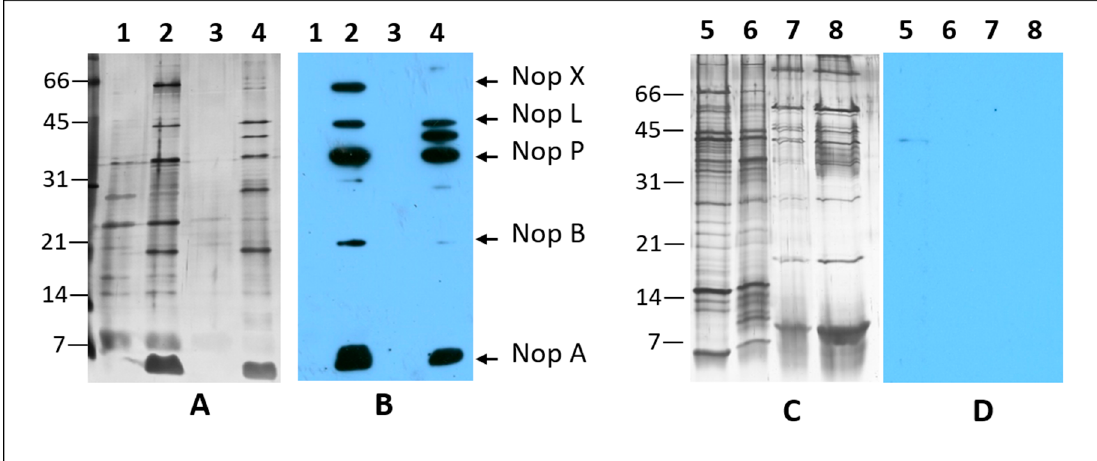
Figure 2. Extracellular protein profile and immunoblot analysis of Nops. Extracellular proteins produced by S. fredii USDA191 (lanes 1 and 2), RCB26 (lanes 3 and 4), B. diazoefficens USDA110 (lanes 5 and 6), and ∆ 136 (lanes 7 and 8) were resolved by 15% SDS-PAGE and silver stained ( A , C ) or transferred to nitrocellulose membrane for immunoblot analysis ( B , D ). Nops were detected with a cocktail of antibodies raised against individual Nop proteins. Odd and even number lanes contain proteins isolated from cells grown in the absence or presence of 1 µ M apigenin or genistein, respectively. The size of the molecular weight markers and the identity of Nops are shown at the sides of the figure.